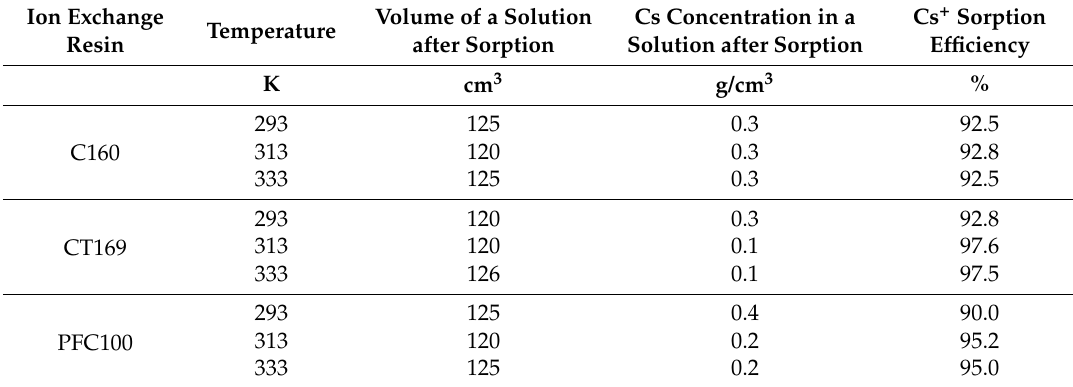
Table 2. Results of the effect of temperature on cesium ion sorption efficiency.